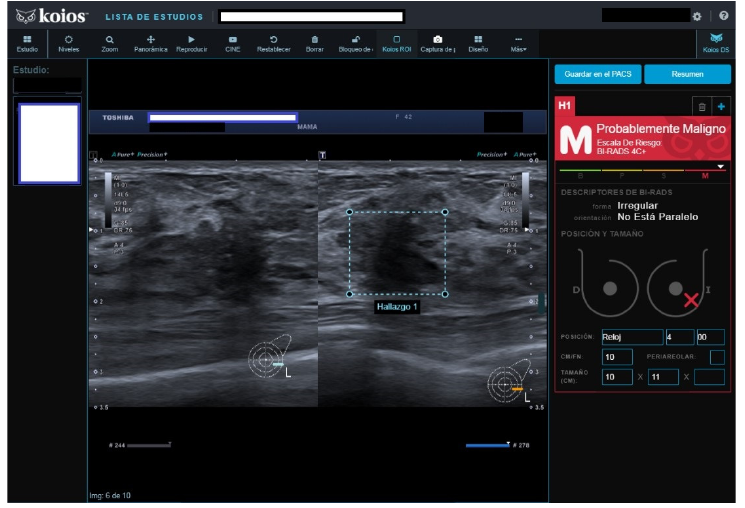
Figure 2. Suspicious image rated B2 by reader because of prior benign core biopsy (usual hyperplasia) and absence of change; rated KPM by KOIOS. Our multidisciplinary committee indicated a new and wider biopsy that was performed with US guidance and vacuum assistance. Pathology reported adenosis.